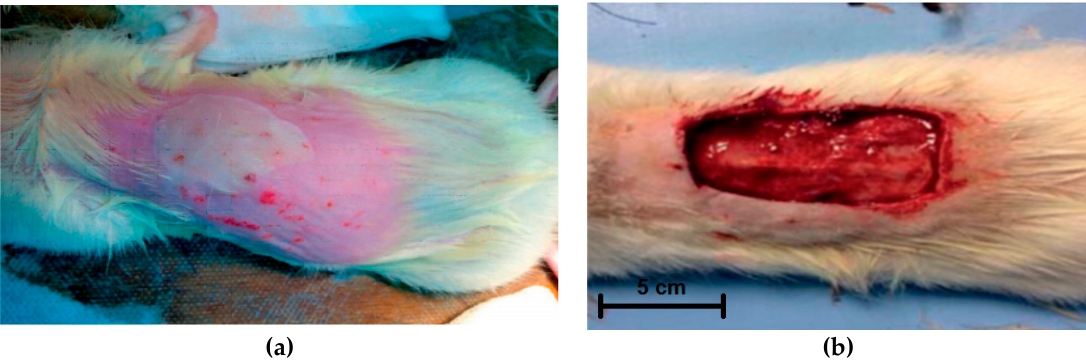
Figure 2. Wound surface before ( a ) and after ( b ) necrectomy.